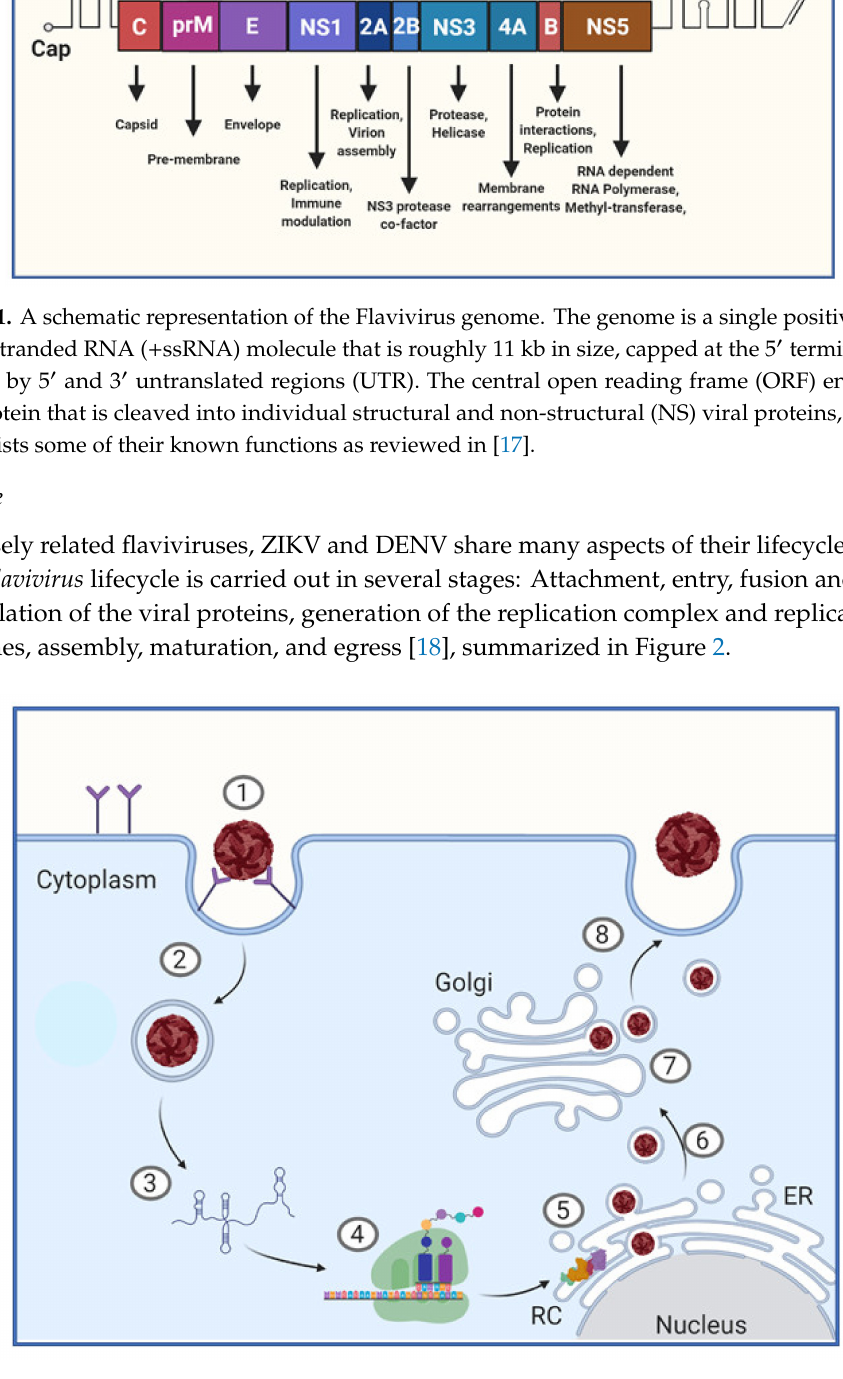
Figure 2. Stagesofthe Flavivirus lifecycle. (1)Attachmentandreceptor-mediatedendocytosis. (2)Membrane fusion and particle disassembly. (3) Genome release into the cytoplasm. (4) Polyprotein translation. (5) Replication complex (RC) formation and genome replication. (6) Virion packaging. (7) Transportation through the trans-Golgi network and virion maturation. (8) Virion egress by